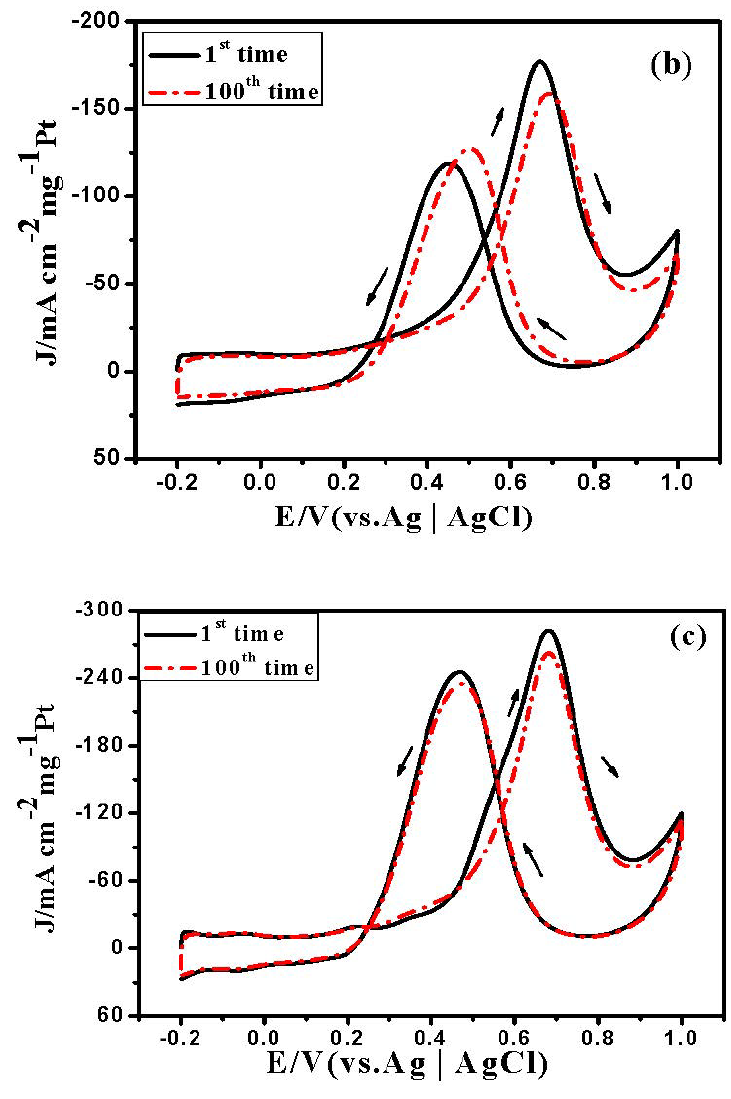
Figure 7. Comparative cyclic voltammograms of the different modified GCE electrodes: ( a ) Pt/GCE; ( b ) Pt/rGO/GCE; ( c ) PMo 12 -Pt/rGO/GCE at 1st time and 100th times in 0.5 M H 2 SO 4 + 1 M CH 3 OH solution. Scan rate: 100 mV·s −1